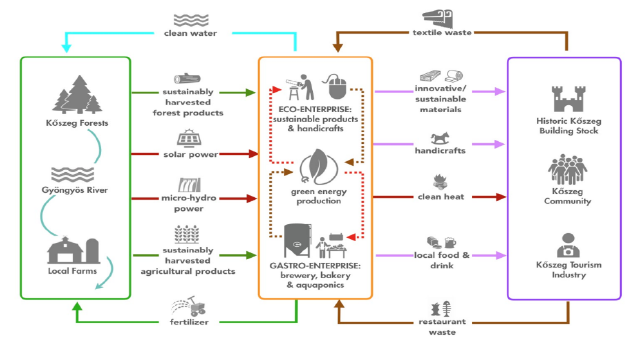
Figure 8. Diagram of the Eco-Innovation Center’s Internaland External Resource Flows.